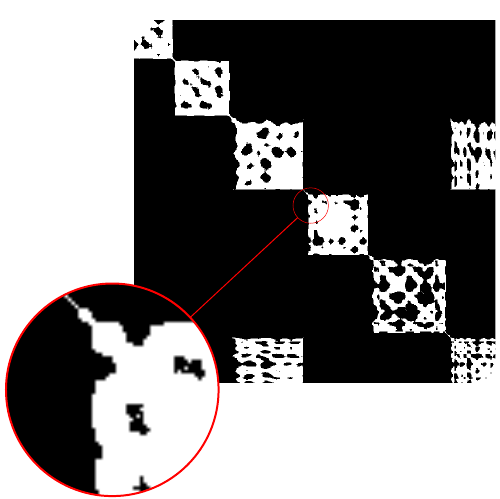
Figure 5 . Filtered time indexed matrix of combinatorial 2-point distances. Magnification shows small compo-